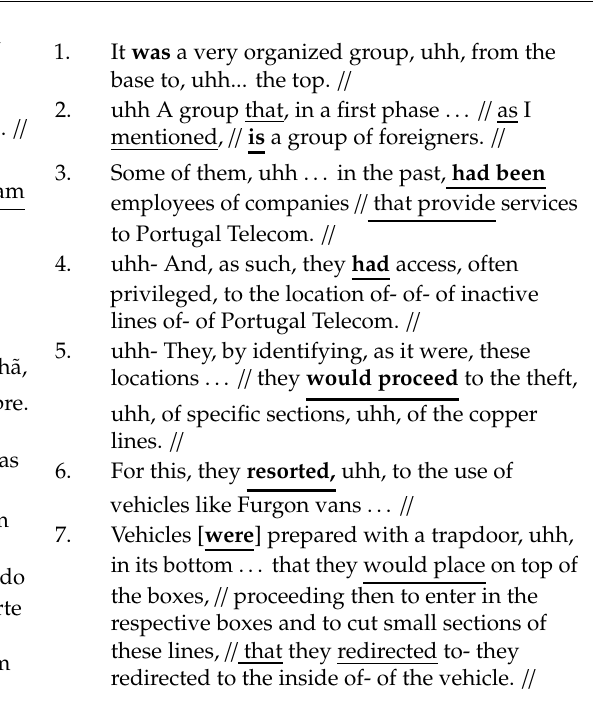
Figure A2. Stimulus 2—Pitch structure. Figure A3. Stimulus 2—Pitch structure. Table A2. Stimulus 2 - Table A2. Stimulus 2 - Transcription.